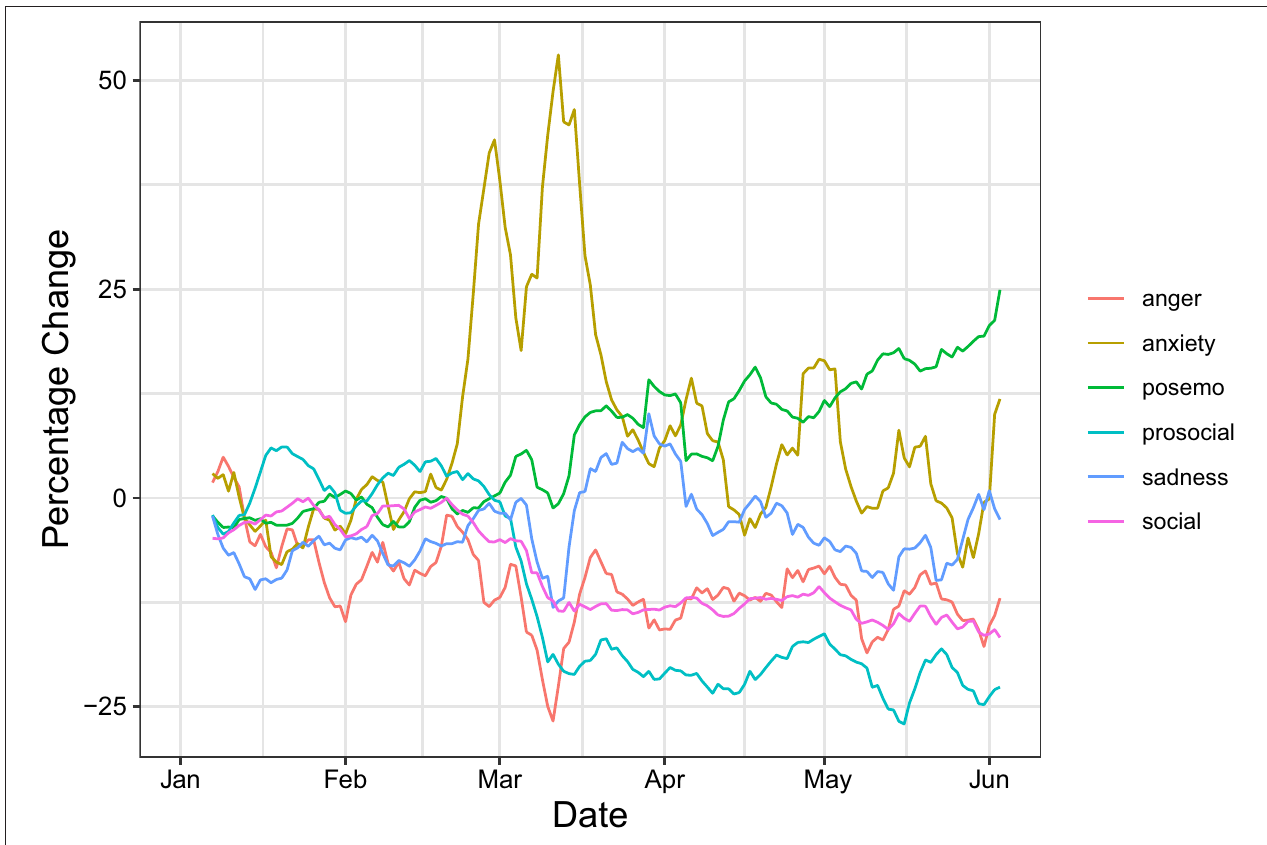
FIGURE 3 | Timeline of the indicators for derstandard.at during the COVID-19 period. Values correspond to the percentage change against the baseline of the full year 2019. Lines are smoothed using a 7 day moving average. To be included, dictionary terms have to appear at least 10 times in both